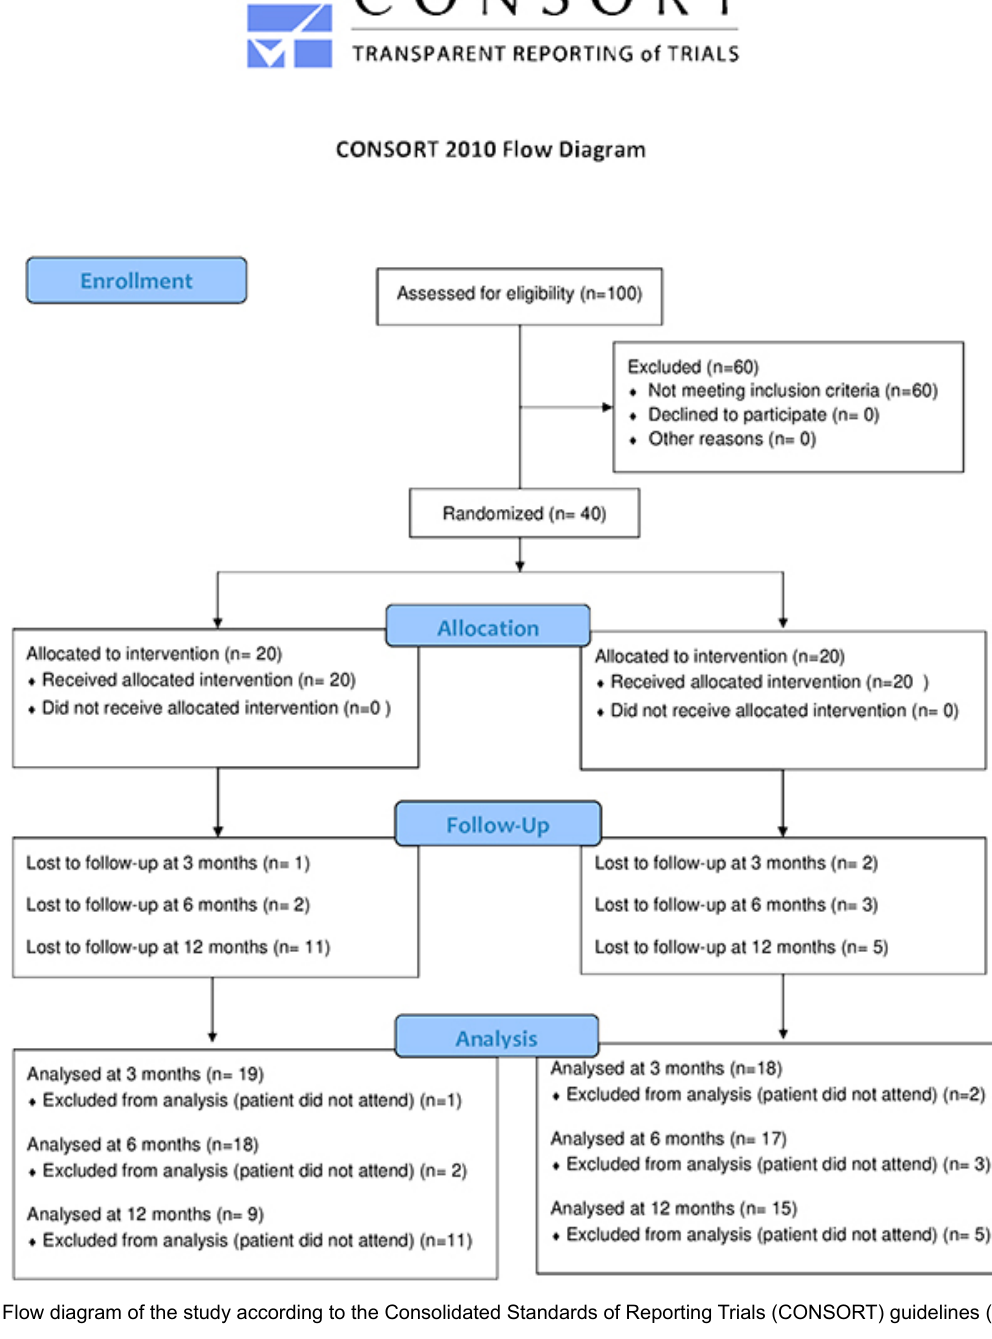
Figure 2- Flow diagram of the study according to the Consolidated Standards of Reporting Trials (CONSORT) guidelines